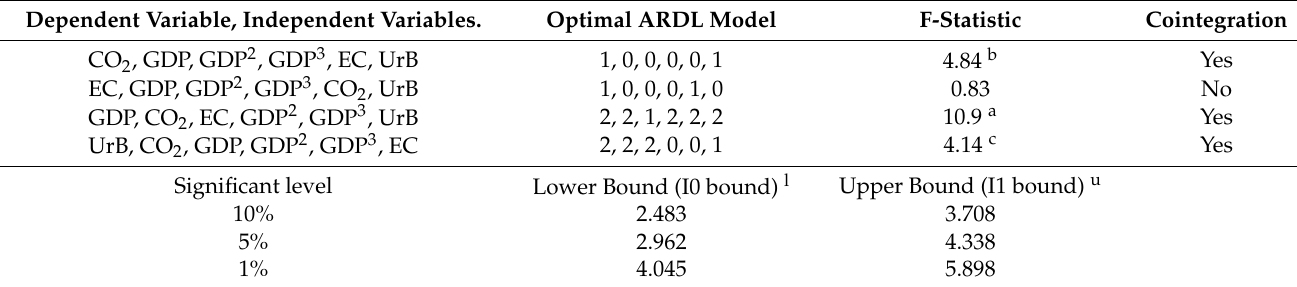
Table 4. ARDL bounds test for